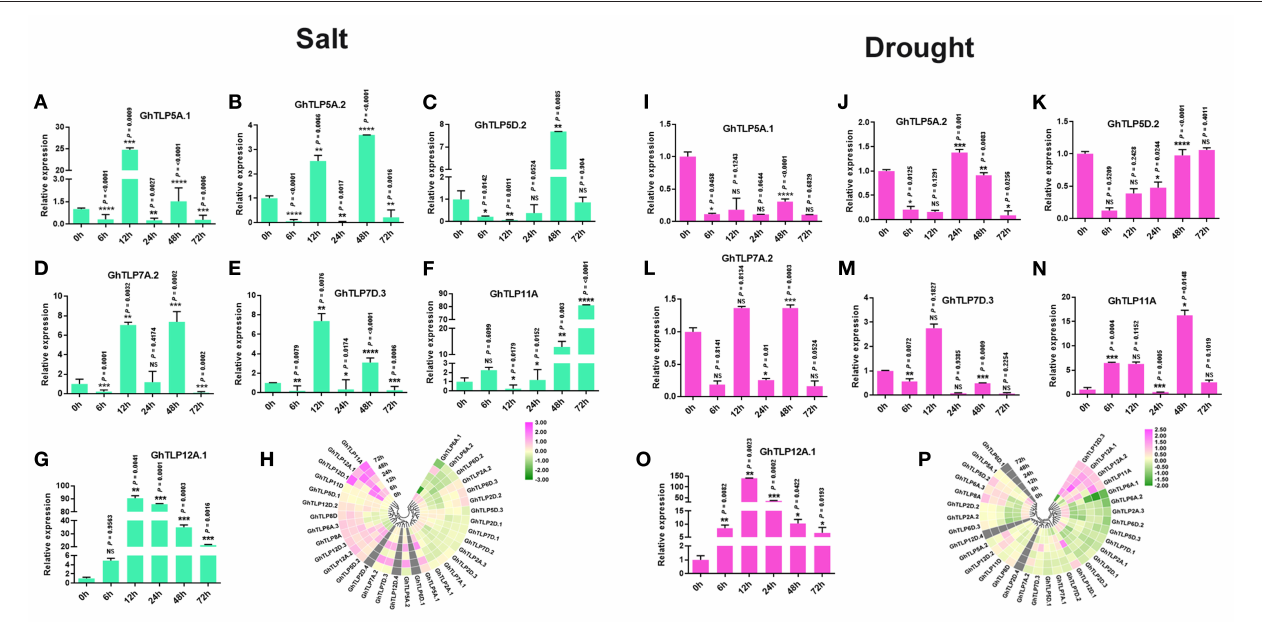
FIGURE 5 | The expression pattern of the TLP gene family members in the G. hirsutum (A–G,I–O) qRT-PCR expression pattern of seven putative genes in normal (0h), 6, 12, 24, 48, and 72h of salt (300MM) and drought (20% PEG solutions PEG8000) stress in cotton. Ubiquitin was used as the loading control. Three replicates were used for each experiment. The statistical analysis was performed, using two-tailed Student’s T -tests. The data are plotted as means ± s.d. The error bars represent standard deviations. The asterisks indicate significant differences: * P < 0 0.1; ** P < 0 0.01; *** P < 0 0.001; **** P < 0.0001. (H,P) Gene expression profiles of TLP genes under salt and drought condition in RNA-Seq, using Log2 (fold change) values.